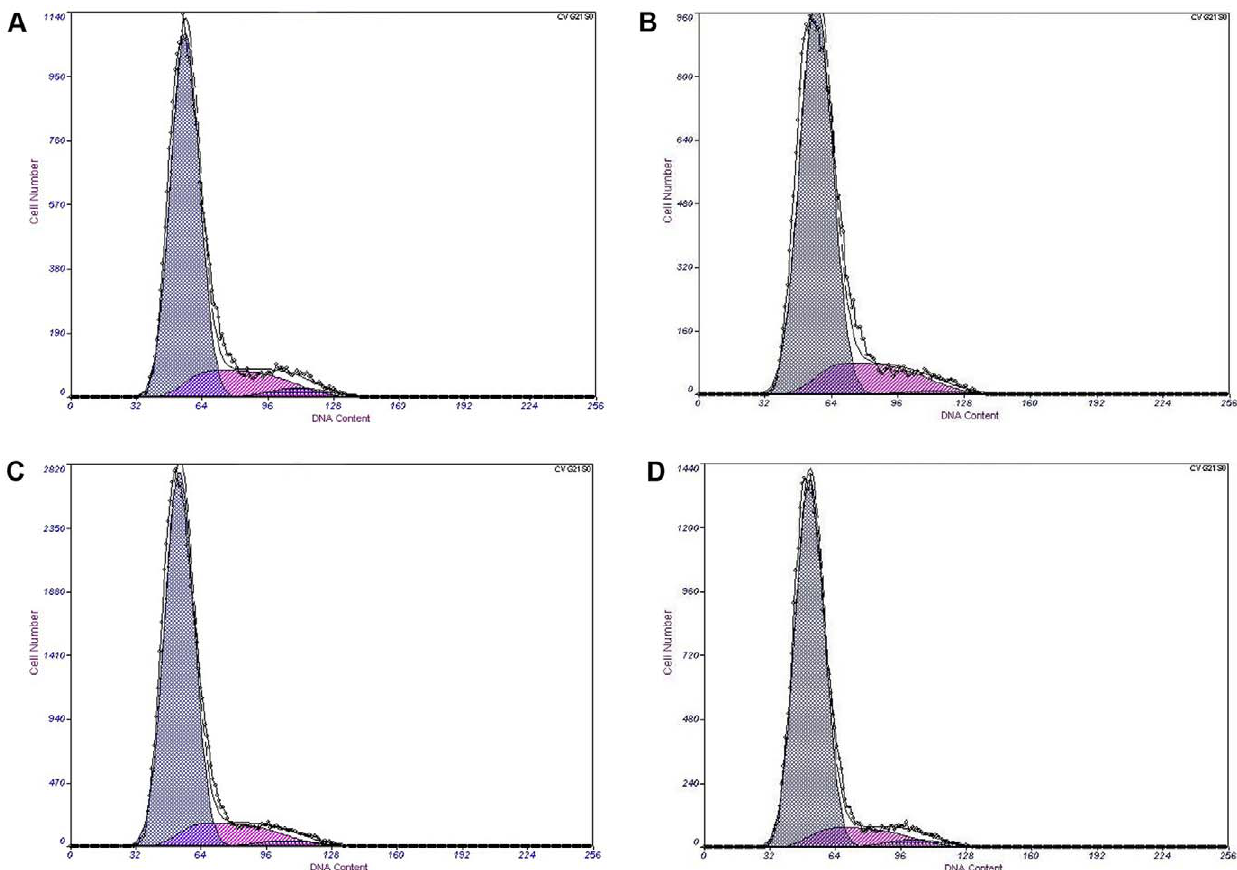
Figure 3. Effect of Artesunate on cell cycle of HSCs. A: control group; B: 150 m mol/L Artesunate group; C: 175 m mol/L Artesunate group; D: 200 m mol/L Artesunate group. In groups 175, 200 m mol/L, the percentage of cells at G0/G1 phase increased significantly ( P , 0.01) , compared with the control group, the percentage of S phase decreased significantly ( P , 0.05), G2 / M phase cells did not obviously change.